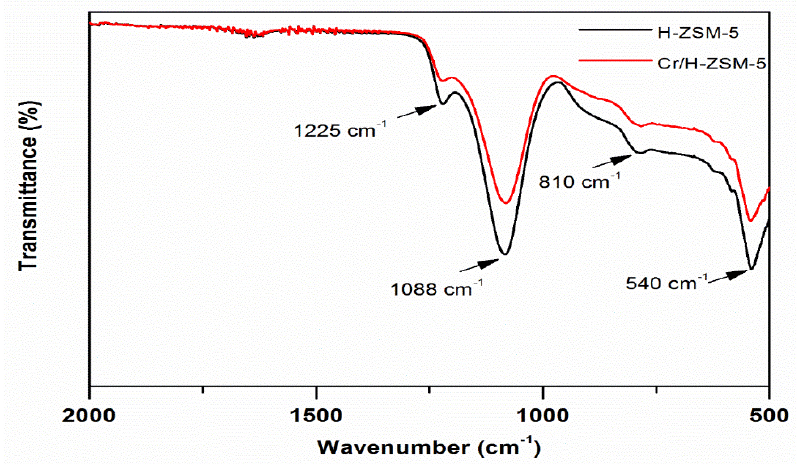
Figure 1. FTIR analysis of H-ZSM-5 and Cr/H-ZSM-5 catalysts.